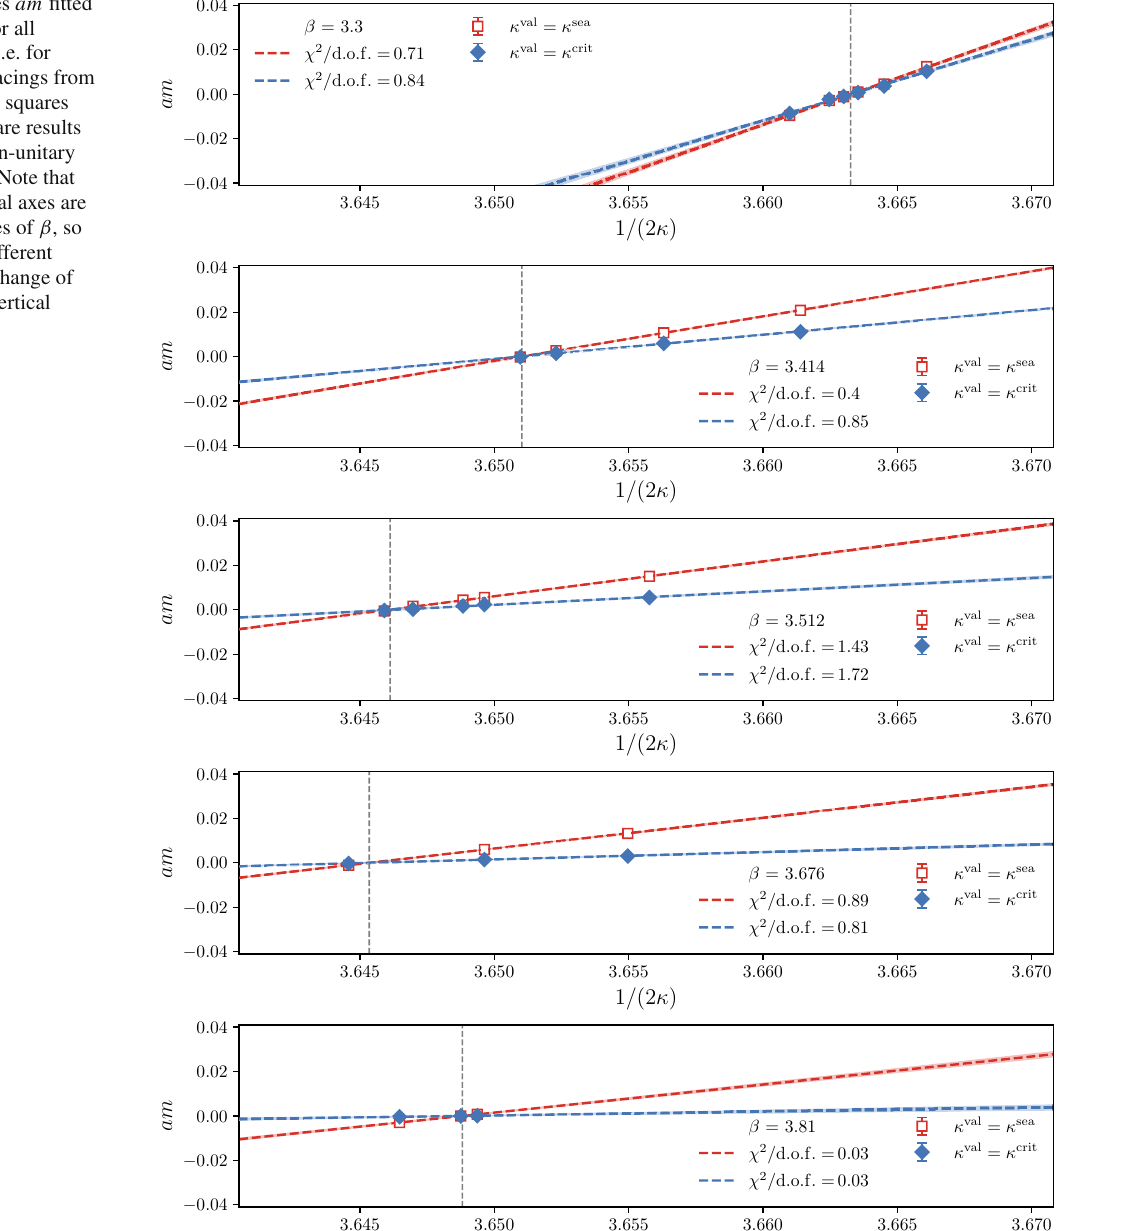
Fig. 3 PCAC masses am fitted linearly in 1 /( 2 κ) , for all simulated β values (i.e. for decreasing lattice spacings from top to bottom). Open squares and filled diamonds are results in the unitary and non-unitary setups, respectively. Note that horizontal and vertical axes are identical for all values of β , so as to highlight the different ranges of κ and the change of κ crit marked by the vertical dashed